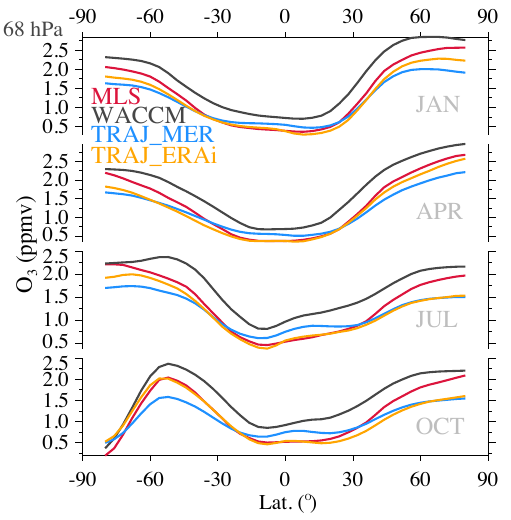
Figure 5. Zonal mean of O 3 at 68hPa during January (JAN), April (APR), July (JUL), and October (OCT) averaged in 2005–2011 from MLS, WACCM, and trajectory results driven by MERRA wind and ERAi wind. Both WACCM and trajectory model results are weighted by the MLS averaging kernels. In October (Antarctic spring time), the South Pole undergoes exceptional depletion of O 3 .